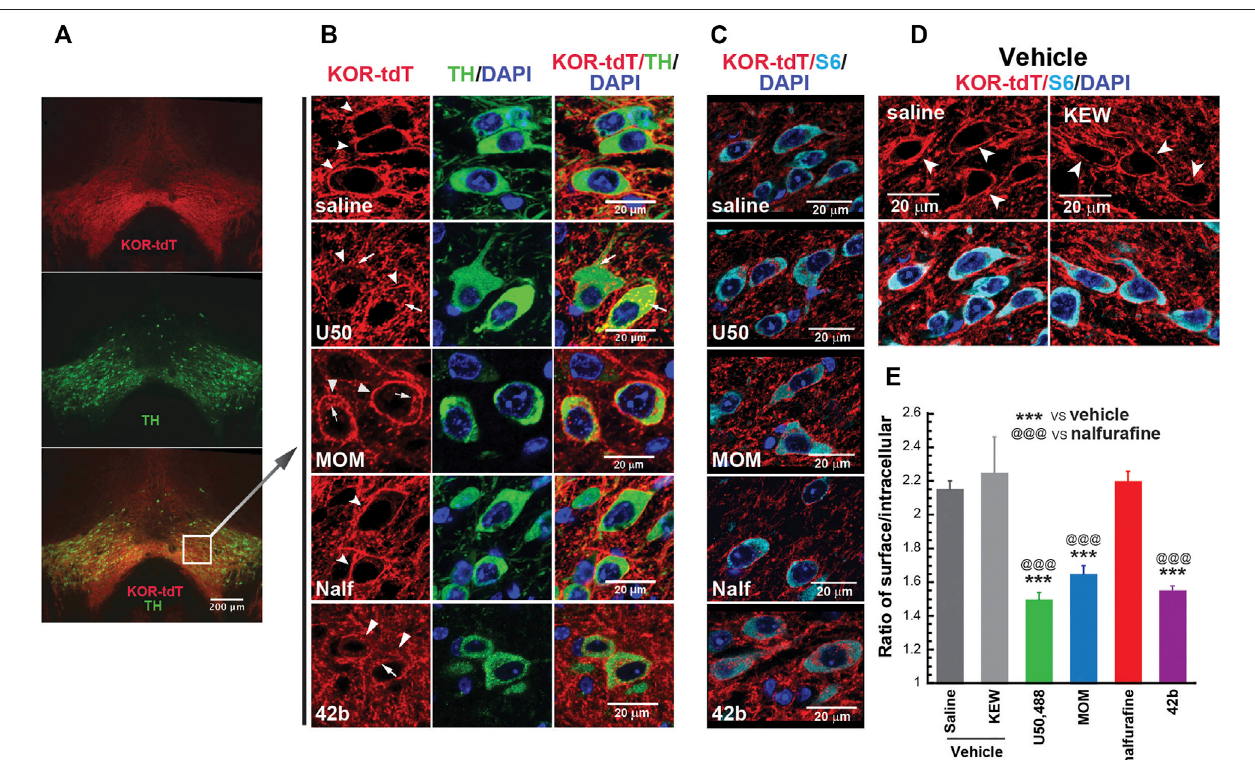
FIGURE 2 | Differential abilities of KOR agonists in promoting KOR internalization in the ventral tegmental areas (VTAs) of male KtdT/KtdT mice. Male KtdT/KtdT micewereinjectedwithsaline,KolliphorEL:ethanol:water(1:1:98)(KEW,vehicleforMOM-SalB),U50,488H(5 mg/kg),MOM-SalB(200 μ g/kg),nalfura fi ne(30 μ g/kg),or 42b(5 mg/kg),and30 minlaterperfusedtranscardiallywith4%paraformaldehyde. (A,B) KOR-tdTandtyrosinehydroxylase(TH)colocalizedinsomeVTAneurons,and treatment with U50,488, MOM-SalB, and 42b induced KOR internalization VTA, but nalfura fi ne did not. Coronal sections of frozen brains were obtained and processed for double immunohistochemistry (IHC) with rabbit antibodies against rabbit anti-red fl uorescent protein (RFP) (red) and mouse antibodies against tyrosine hydroxylase (TH) (green). Sections were also stained with DAPI for nuclei (blue). (A) Epi fl uorescence microscopy images of the VTA. Scale bar = 200 μ m. (B) A layer of confocal microscopy image. Scale bar = 20 μ m. Note that many neurons express both TH and KtdT. Arrows point to internalized receptors, whereas arrow heads indicatereceptorsonmembranes.Theexperiment wasperformedonthreemiceforeachgroup (C – E) Quantitationofagonist-inducedKORinternalization. (C) IHCwas performed oncoronal sections containingtheVTA withantibodies against tdT (red) and S6(cyan), aribosomal protein in cytosol foridenti fi cation ofallthecells. Sections were also stained with DAPI for nuclei (blue). (D) KEW did not cause KOR internalization, like saline. KEW is the vehicle we used for MOM-SalB. (E) Quantitation of KOR internalization was performed on three sections/mouse at different rostral – caudal positions. Fifteen to 20 neurons per section and three focal planes per neuron from imagestacksweremeasured.Thus,ontheaverage,about50neurons/mousewerequanti fi edforinternalizationasdescribedinthe Methods section.Experimentswere performed on three mice/group. *** p < 0.001, compared with saline; @@@ p < 0.001, compared with nalfura fi ne, by one-way ANOVA followed by Tukey ’ s multiple comparisons test. Each value is mean ± SEM ( n = 3